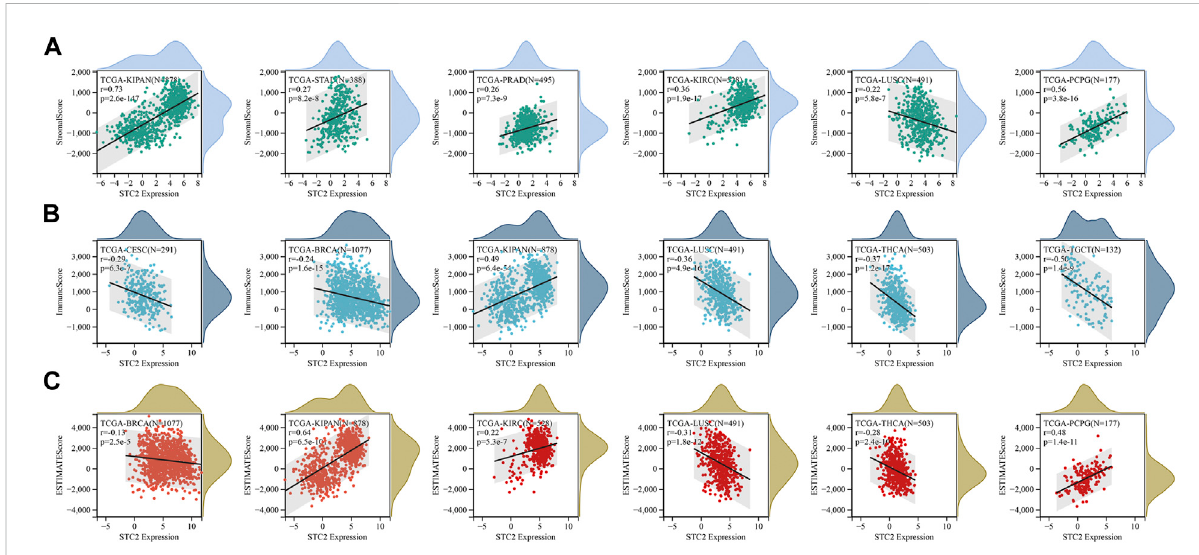
FIGURE 8 STC2 expression correlated with immune in fi ltration. (A) Correlation between STC2 expression and stromal score in six cancer types; (B) Correlation between STC2 expression and immune score in six cancer types; (C) Correlation between STC2 expression and estimate score in six cancer